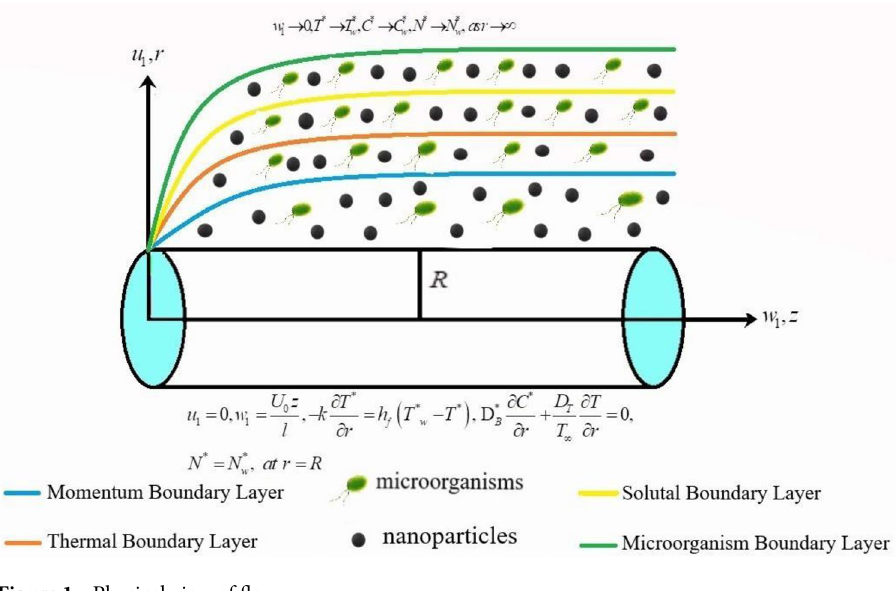
Figure 1. Physical view of